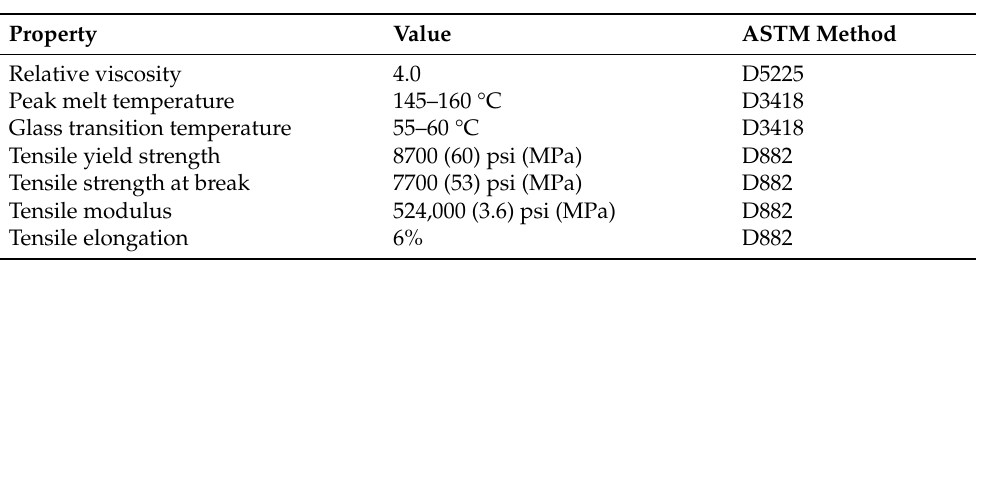
Table 1. Physical and mechanical properties of PLLA